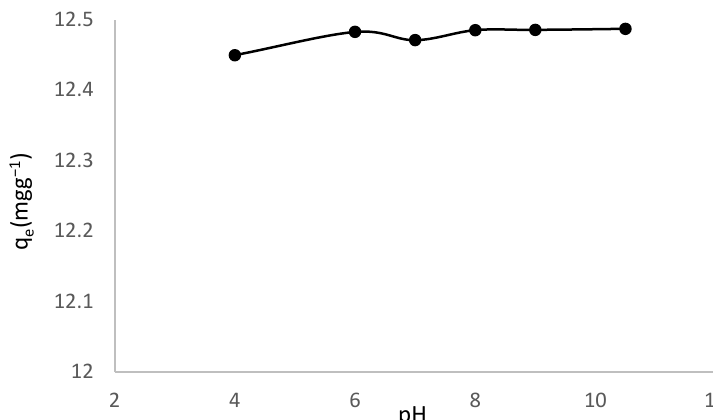
Figure 2 . Effect of pH on adsorption of MV onto HNC .